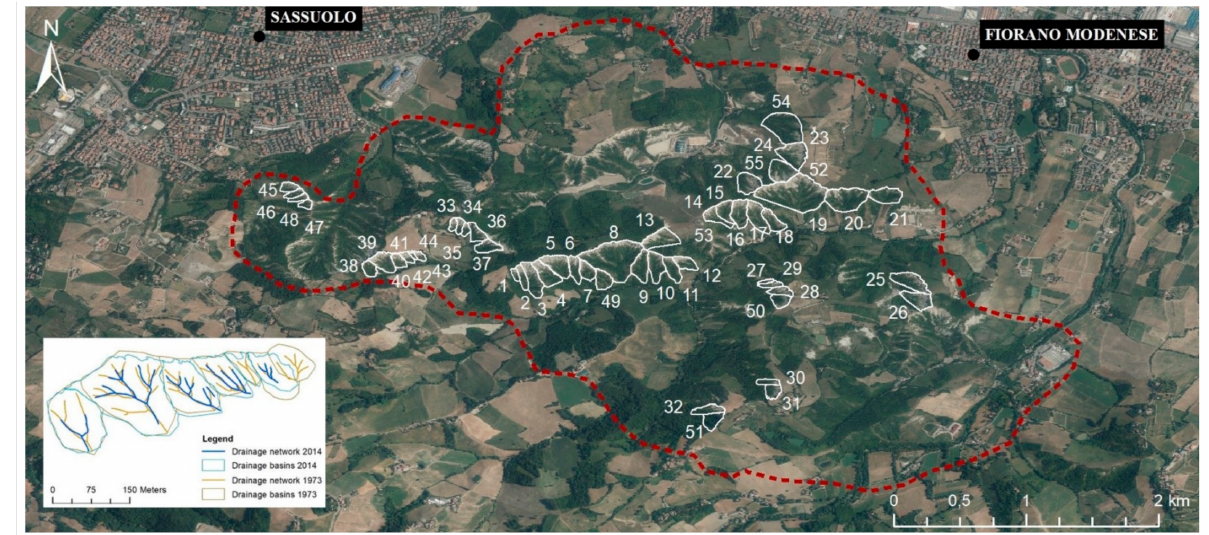
Figure 5. Badlands inventory map (white line) in the study area (red dashed line). The box shows an example of the area variation over a 40-year period and the segment of furrows